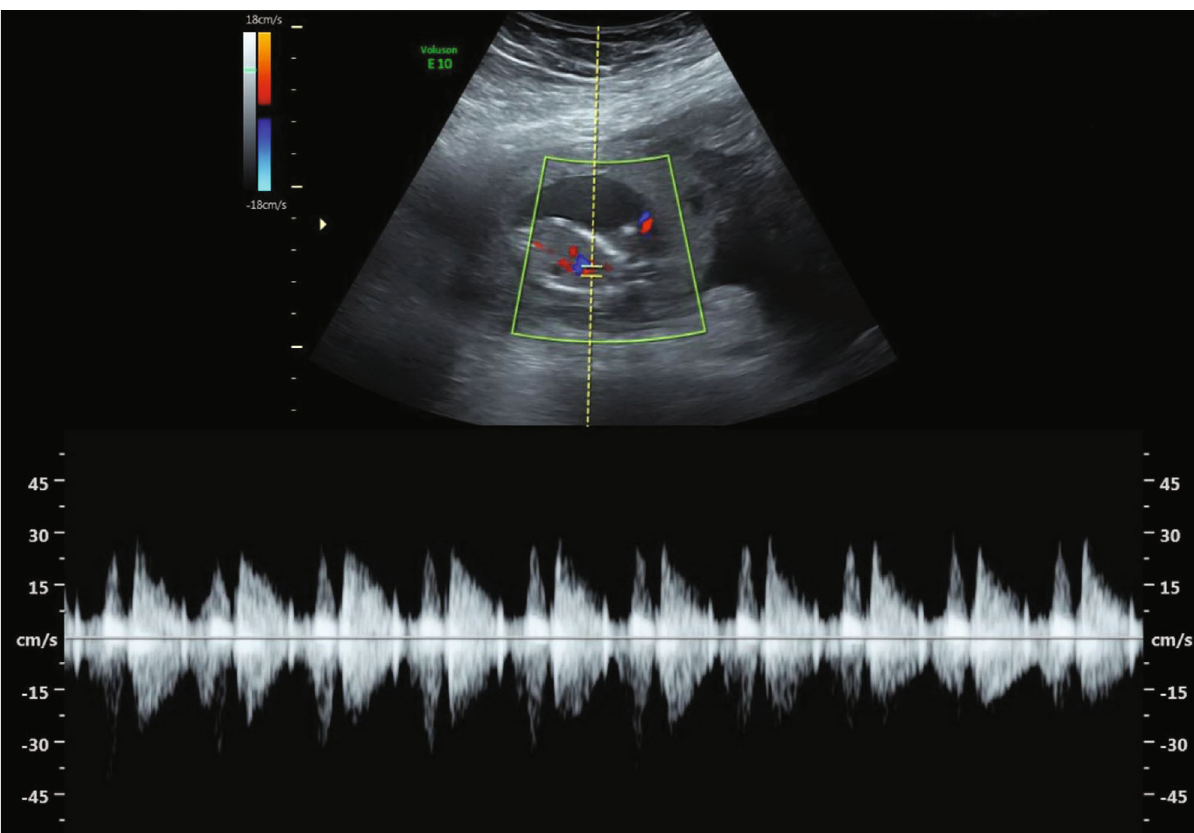
Figure 2: Ultrasound shows extrauterine pregnancy and the fetal heart rate